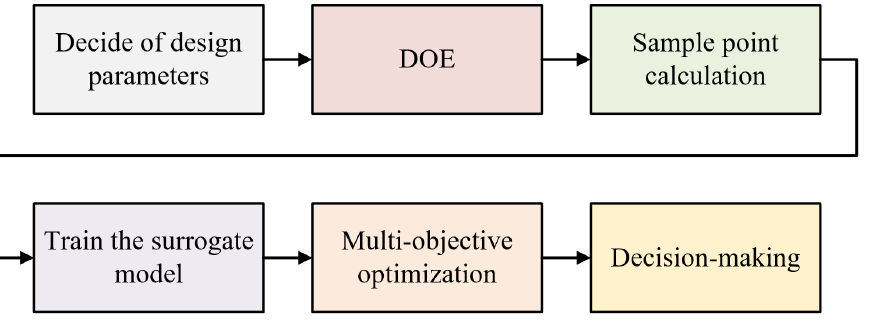
Figure 1. Process